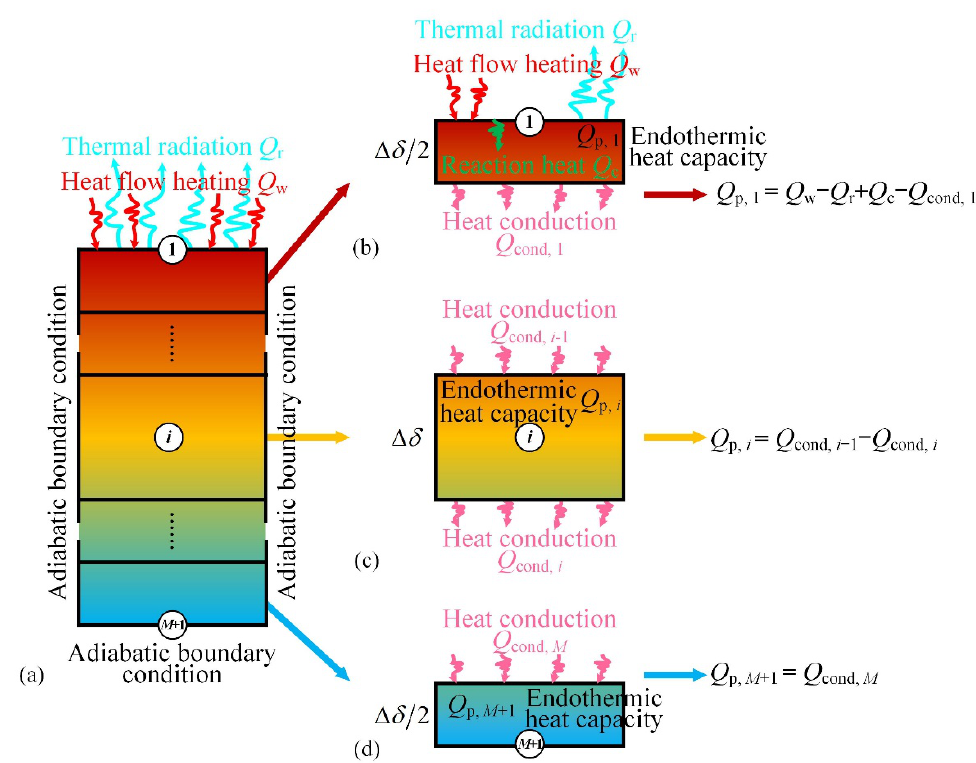
Figure 4. Schematic diagram of heat transfer: ( a ) boundary condition; ( b ) element 1; ( c ) element i ; ( d ) element M + 1.